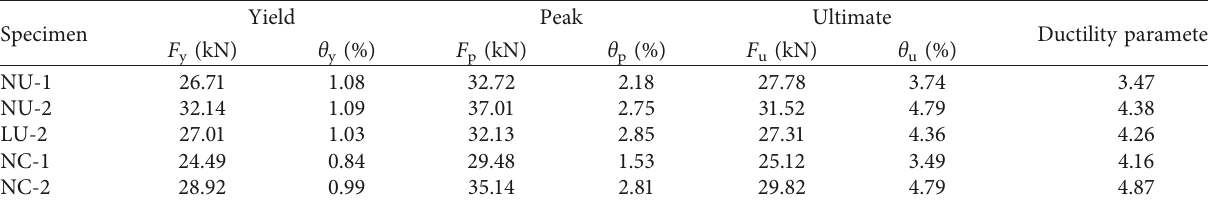
Figure 8: Column skeleton curve: (a) NU-1and NU-2; (b) NU-1and LU-2; (c) NU-1, NC-1, and NC-2. Table 5: Test result of